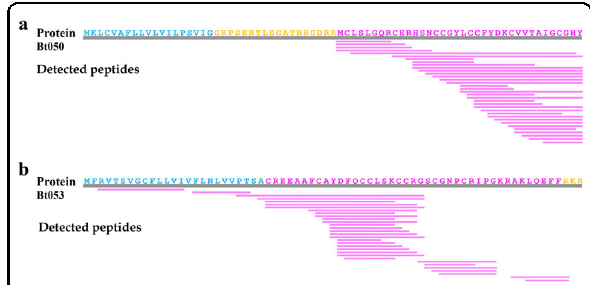
Fig. 7 Mapping examples of sequenced peptides to the examined conopeptides. Representative peptides are Bt050 ( a ) and Bt053 ( b ). Sequences highlighted in blue, orange, and rosy red are signal peptides, pro-/post-peptides, and mature peptides, respectively.